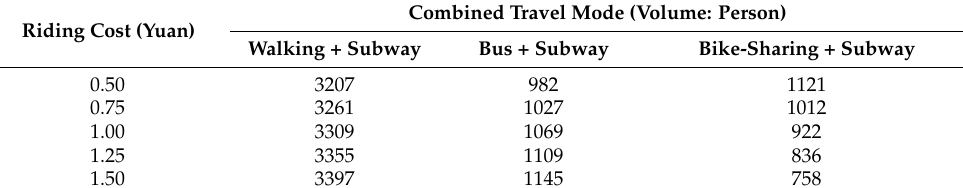
Table 6. Volume variation of three modes.